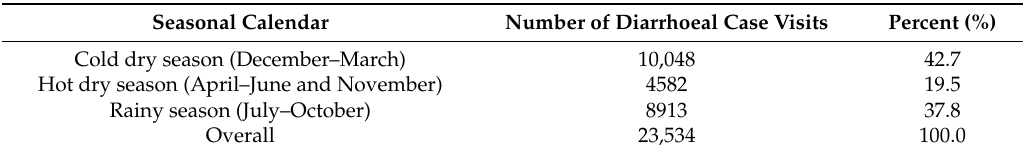
Table 3. Seasonal distribution of diarrhoeal cases for the period 2011–2014 in the health district of Mbour, Senegal.